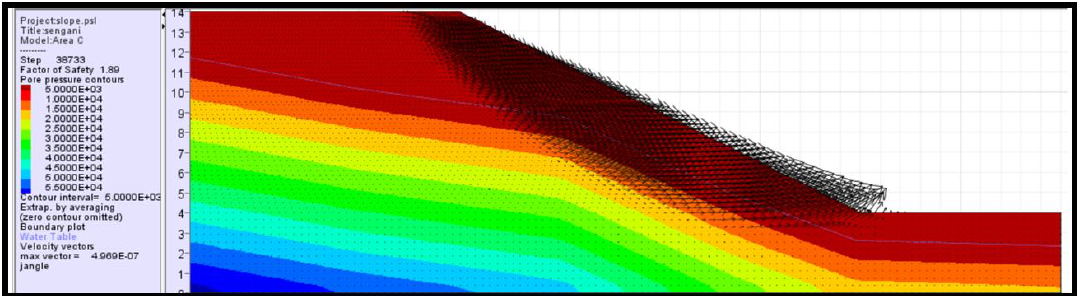
Figure 35. Simulated water pore pressure of the soil slope using FLACSlope in sunny conditions with a water table with 1000 m 3 volume of water.